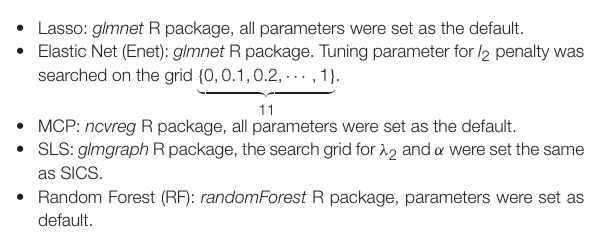
Box 1 | Parameter settings for competing